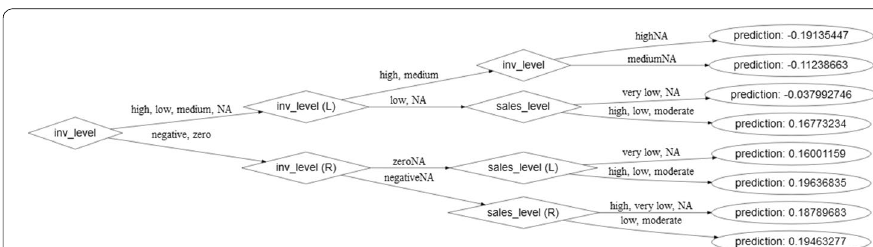
Fig. 15 GBM model’s inventory and sales level distribution for backorder